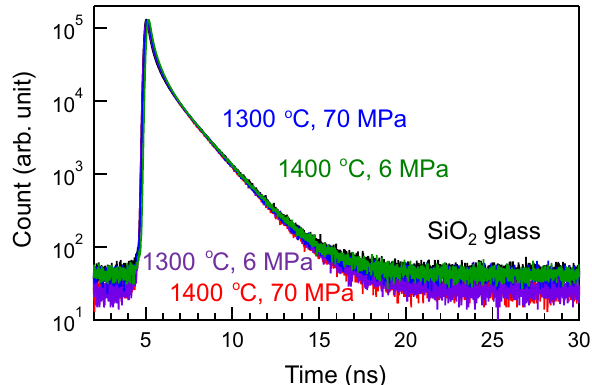
Figure 2. Positron decay curves of SPS-SiO 2 glasses prepared at different conditions along with that of conventional SiO 2 glass.